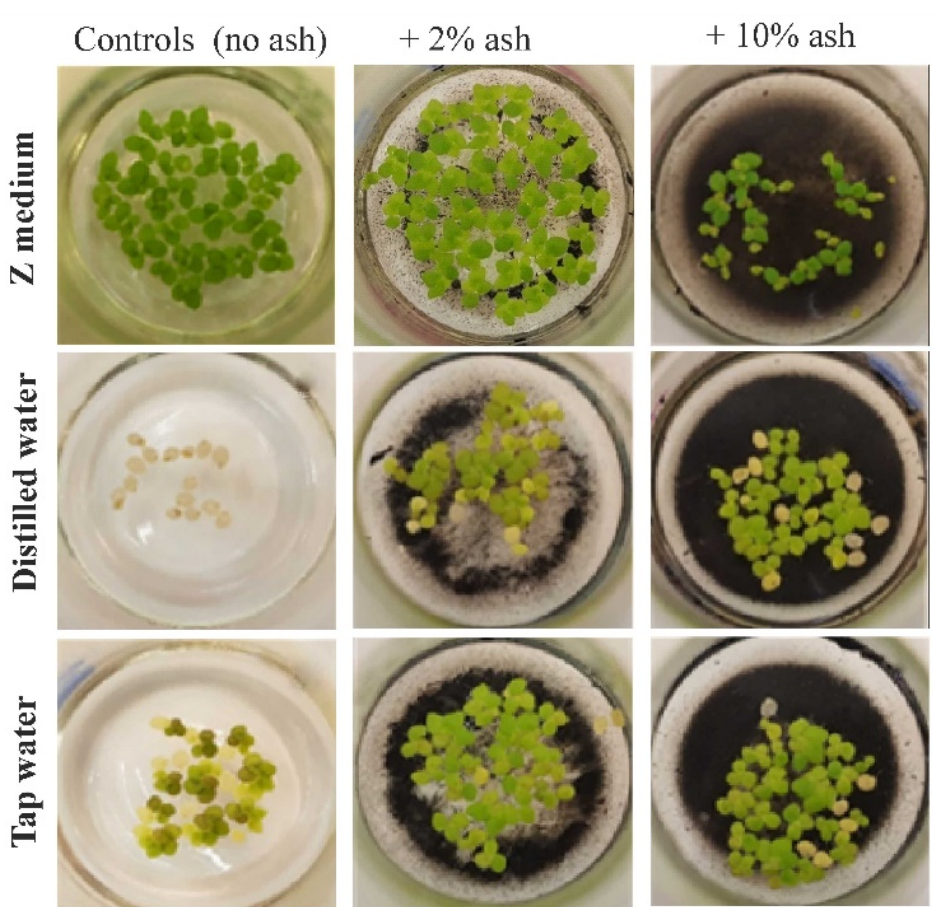
Figure 1. Growth kinetics of S. polyrrhiza plants (after 14 days) grown on different medium variants. Macrophytes throughout the 14-day period of the experiment were cultured in a phytotron room at 24 ◦ C, under constant lighting with PHILIPS MASTER TL-D lamps, 2 × 18 W/840. S. polyrrhiza plants were grown in 250 mL Erlenmayer flasks with 100 mL respective media for each variant in triplicate. On the last day of the experiment, the following analyses were performed: (1) cytological tests concerning root meristems and (2) physiological ones.